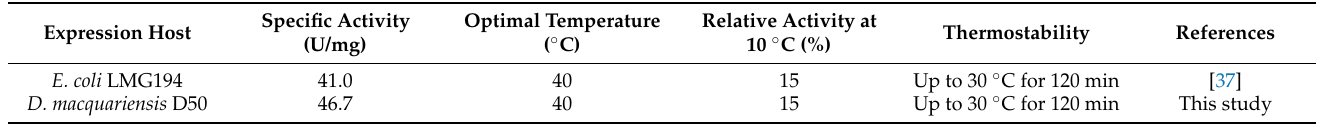
Figure 5. SDS-PAGE protein patterns of fractions obtained after successive purification steps of the recombinant Paracoccus sp. 32d β - D -galactosidase produced in the D. macquariensis D50 expression host. Lane 1—protein molecular weight marker (Protein precision plus unstained, BioRad, Hercules, CA, USA), lane 2—pooled fraction after ion-exchange chromatography on HiTrap Q FF column, lane 3—pooled fraction after ion-exchange chromatography on Mono Q 5/50 GL column, lane 4—pooled fraction after size exclusion chromatography on Superdex 200 pg column. Table 7. Comparison of selected properties of recombinant Paracoccus sp. 32d β - D -galactosidase produced in two different expression